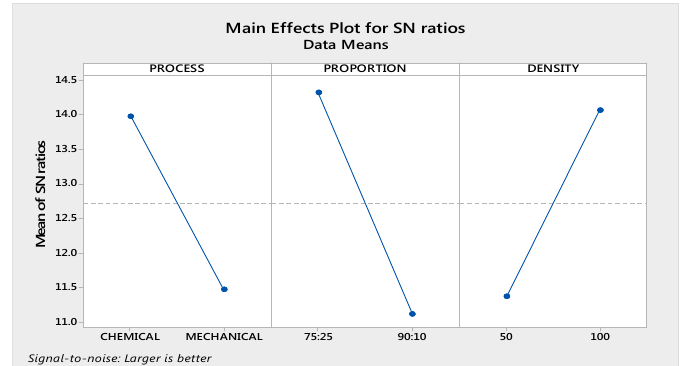
Figure 6. Main effects for signal-to-noise SN ratios of electrical conductivity.